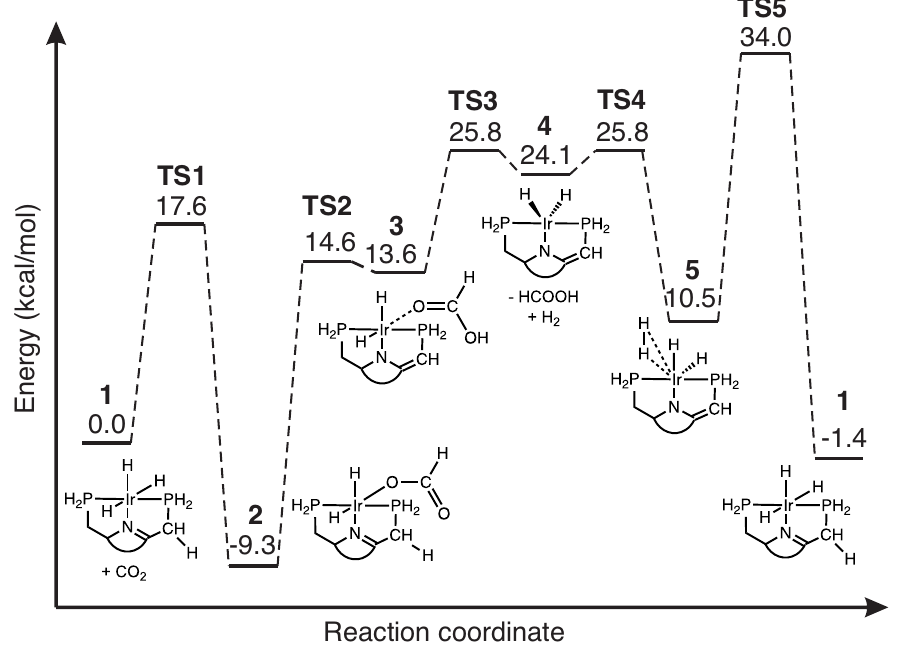
Figure 3. Energy diagram for the catalyzed reactions R1 – R5 , relative to the initial reactant van der Waals complex of 1 . For simplicity, the energies have been calculated by adding the activation and reaction energy of the next reaction step of the cycle, to the product energy of the previous reaction step. DLPNO-CCSD(T)/def2-TZVP/def2-ECP(Ir) level of theory performed at the end points of the DFT IRC calculations with B3LYP/6-31G(d,p)/SDD(Ir). According to Table 2 and Figure 3, reactions R1 —CO 2 addition (E a = 17.6 kcal/mol), R2 —hydrogen transfer (E a = 23.9 kcal/mol), and R5 —catalyst regeneration (E a = 23.5 kcal/mol)